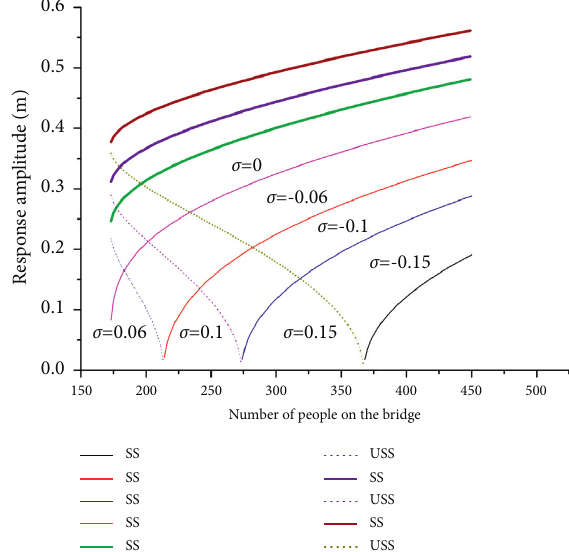
Figure 6: Amplitude frequency response curve ( 􏽢 ζ SS: stable solution, USS: unstable solution).